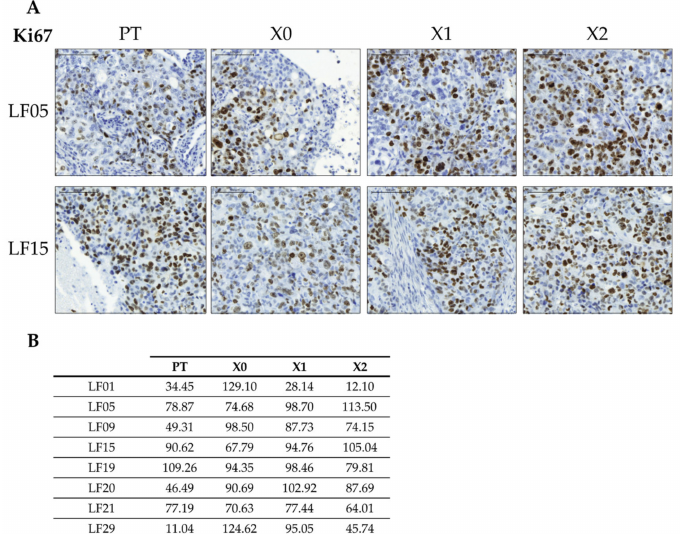
Figure 7. Correlation of Ki67 expression throughout the PDX passages. ( A ) Immunohistochemistry of Ki67 in samples LF05 and LF15 throughout passages X0–X2. All images at 20 × magnification. ( B ) Ki67 mean H-scores of primary tumors and PDX passages of indicated